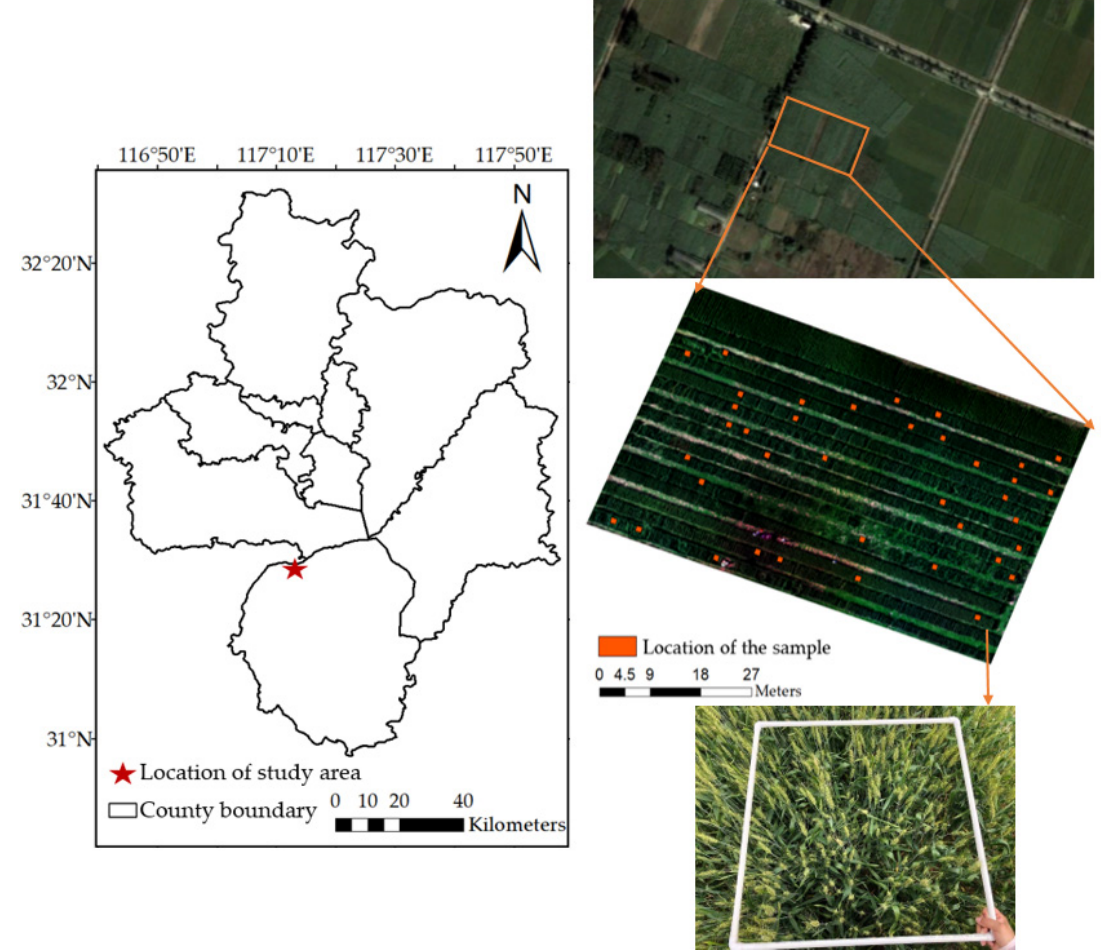
Figure 1. Location of the study area and samples. The red rectangle in the map on the top right marks the boundary of the experimental field. The center-right map is a UAV multispectral image captured on May 5th. The photo on the bottom right shows the range of the sample.